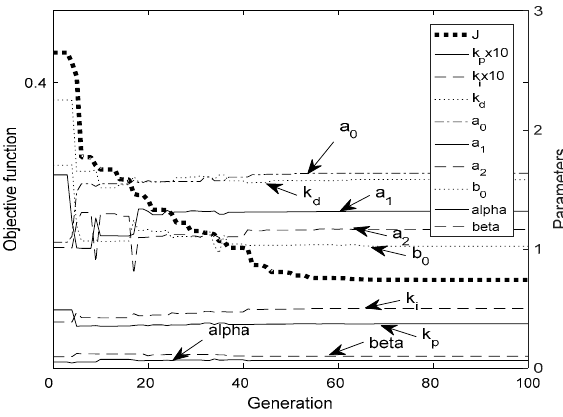
Figure 5. RCGA-based evolutionary tuning for IFOPTD.